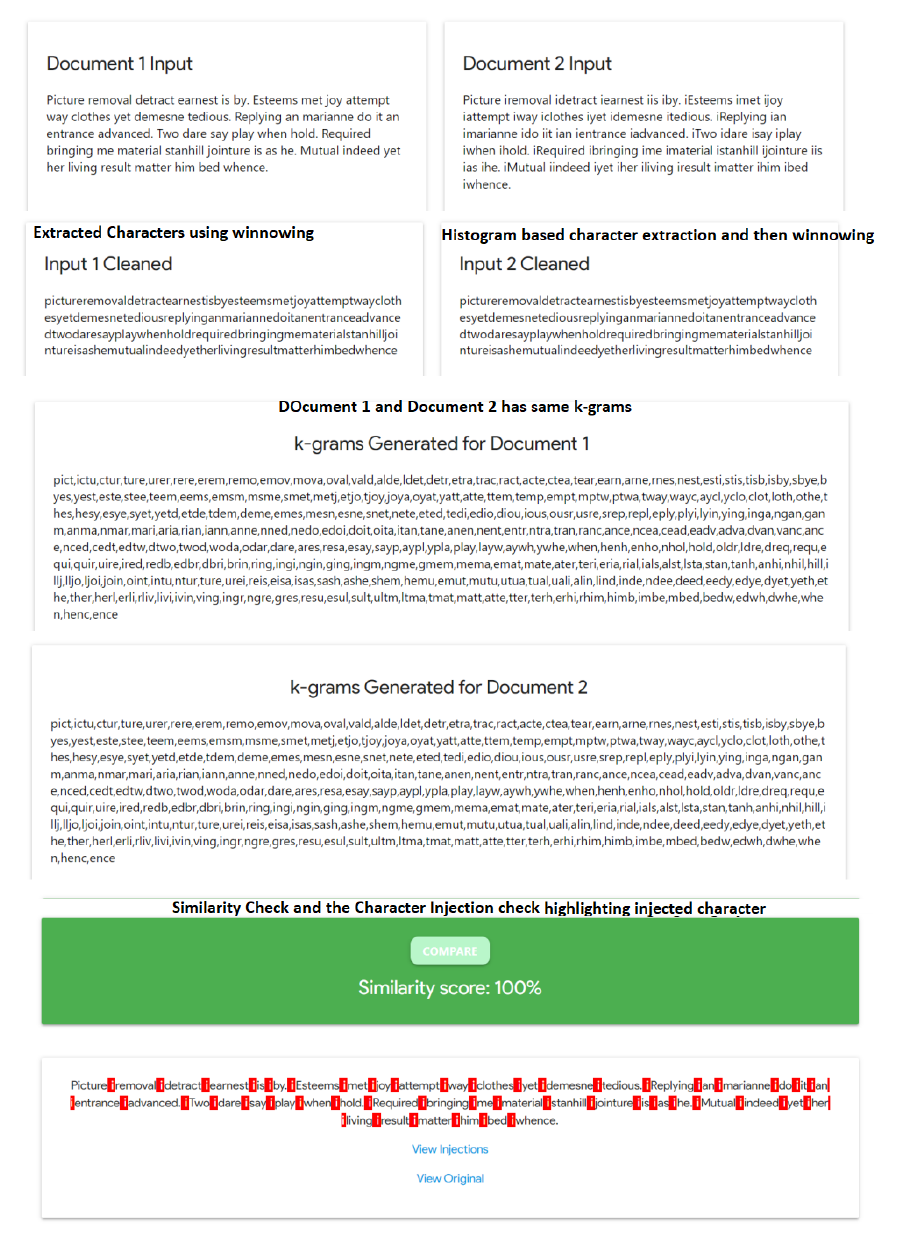
Figure 15. DocCompare-test